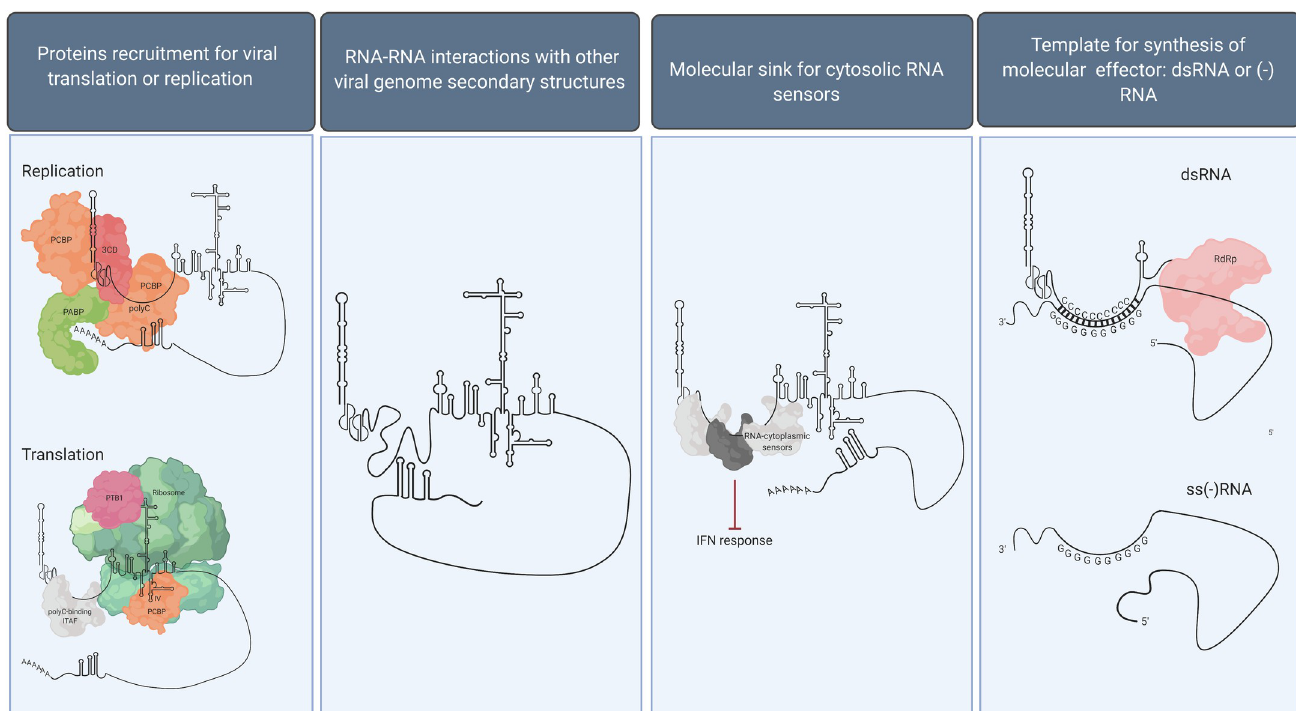
Fig 2. Possible molecular mechanisms mediating the polyC function. Detailed discussion of each potential molecular mechanism is included in the text. Created with BioRender.com. IFN, interferon; ITAF, IRES trans-acting factor; PABP, polyA-binding protein; PCBP, poly(rC)-binding protein; polyC, polycytidine; PTB, polypyrimidine tract–binding